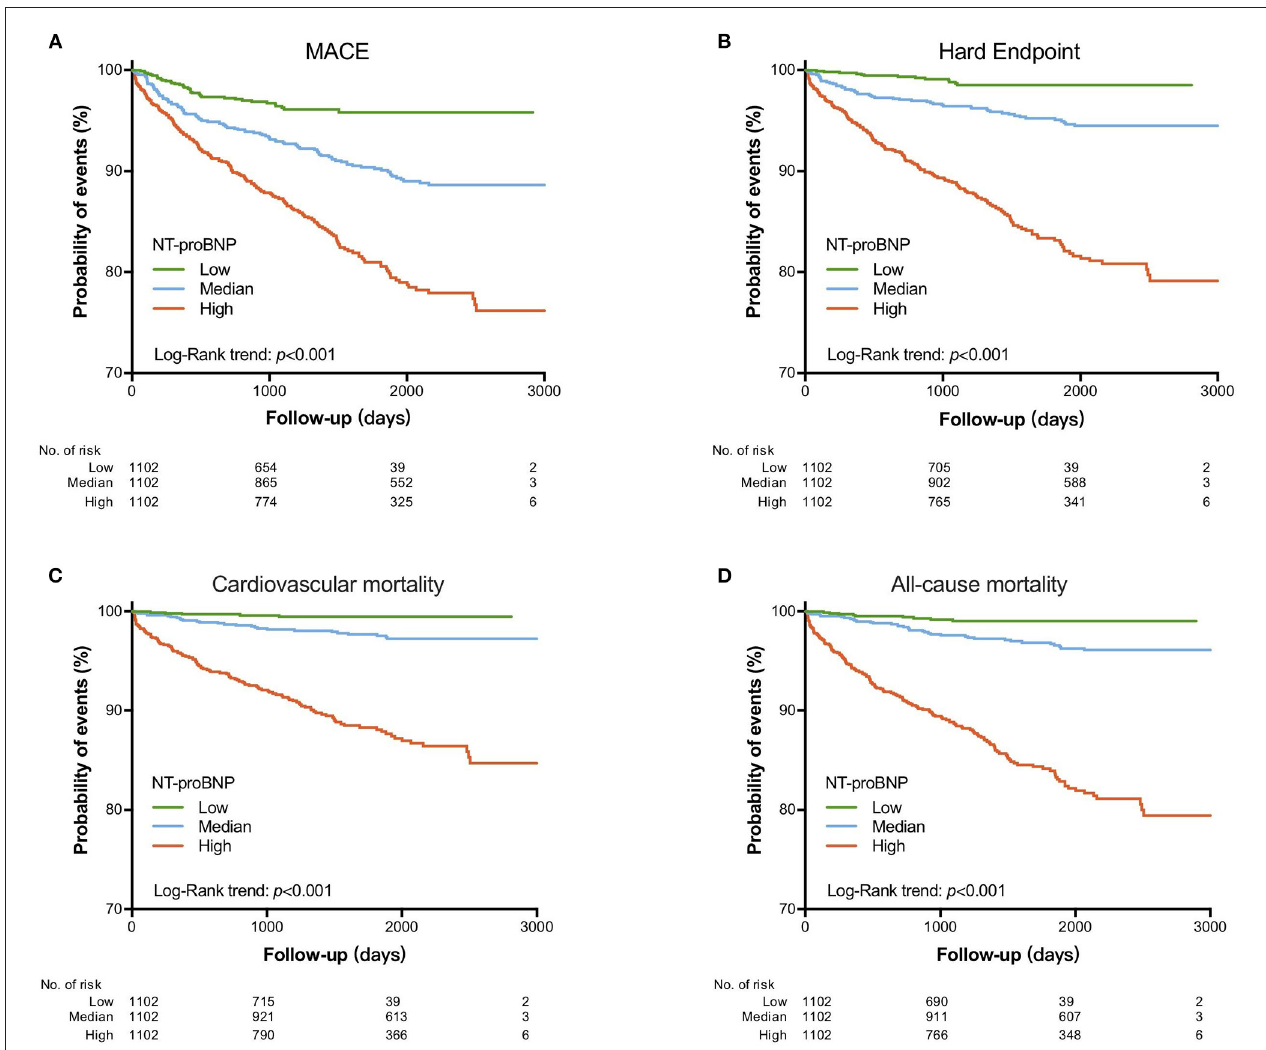
FIGURE 1 | Kaplan–Meier curve for cardiovascular events according to NT-proBNP levels. (A) MACE; (B) hard endpoint; (C) cardiovascular mortality; (D) all-cause mortality.